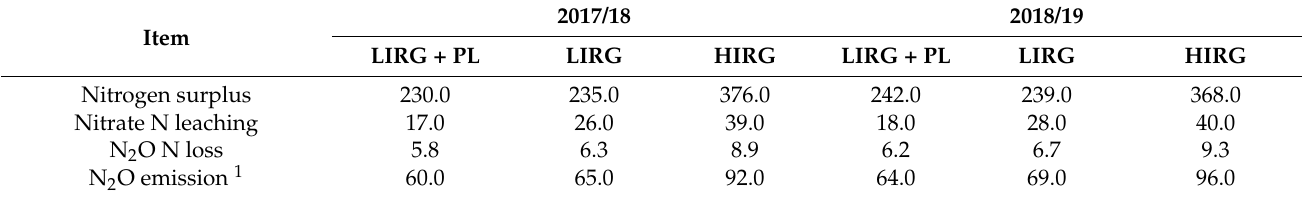
Table 6. Estimated nitrogen (N) surplus, nitrate leaching loss and nitrous oxide (N 2 O) N loss (kg N/ha per year), and nitrous oxide emission (equivalent to CO 2 tonne per year) for lower input ryegrass + plantain-based (LIRG + PL; perennial ryegrass, Italian ryegrass, white clover, and plantain diverse mix, and plantain–white clover mix swards, 3.5 cow/ha and herbage received 150 kg nitrogen/ha), lower input ryegrass-based (LIRG; perennial ryegrass–white clover mix sward, 3.5 cow/ha and herbage received 150 kg nitrogen/ha), and higher input ryegrass-based (HIRG; perennial ryegrass ryegrass–white clover mix sward, 5 cow/ha and herbage received 300 kg nitrogen/ha) irrigated diary systems over two milking years, 2017/18 and 2018/19. Values estimated using Overseer ® (Version